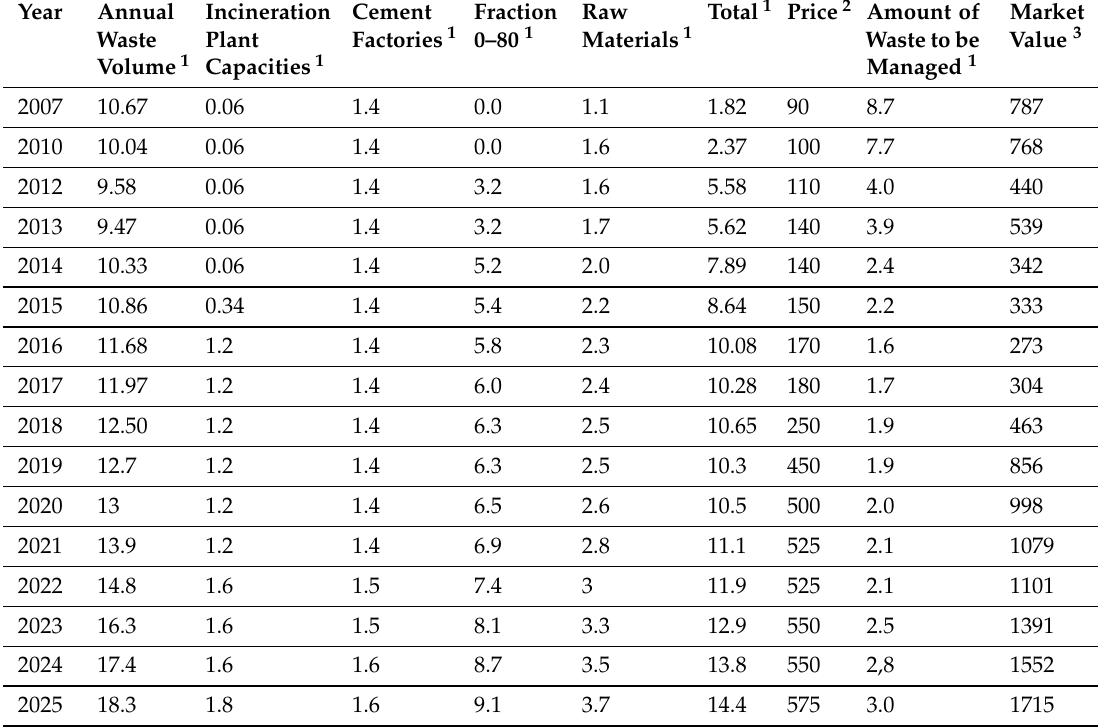
Table 6. Waste management options and market